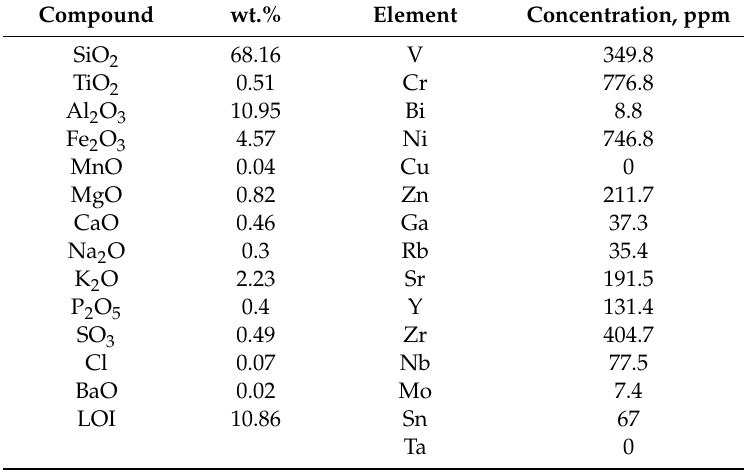
Table 9. Chemical composition and trace elements of diatomaceous earth determined by means of the X-ray fluorescence method.